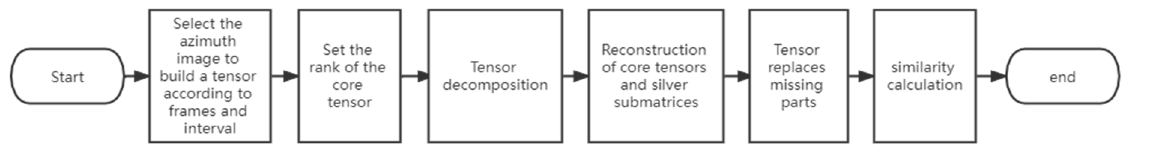
Figure 5. Flowchart of vehicle target SAR image reconstruction based on non-negative Tucker decomposition.